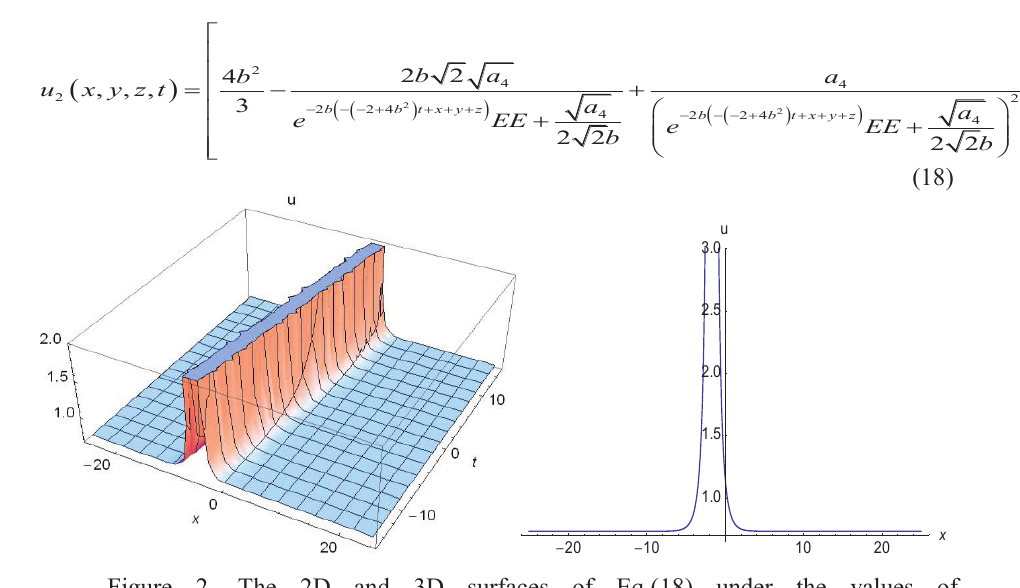
Figure 2. The 2D and 3D surfaces of Eq.(18) under the values